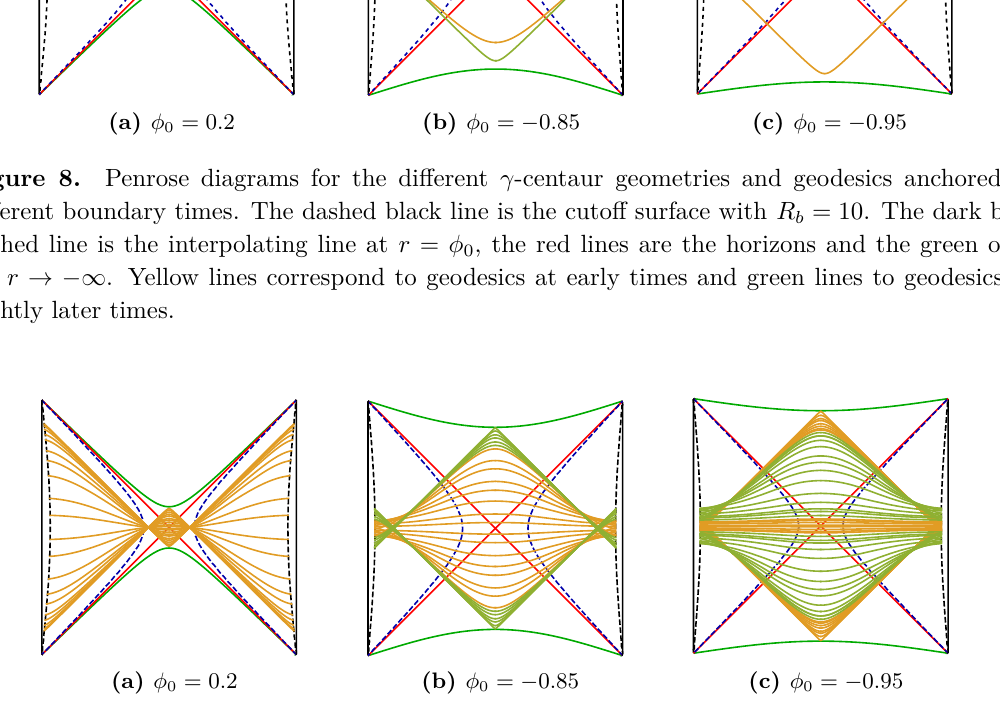
Figure 9. Same Penrose diagrams as in figure 8, but here we plot geodesics for several different boundary times. Note that the geodesics stop existing for large